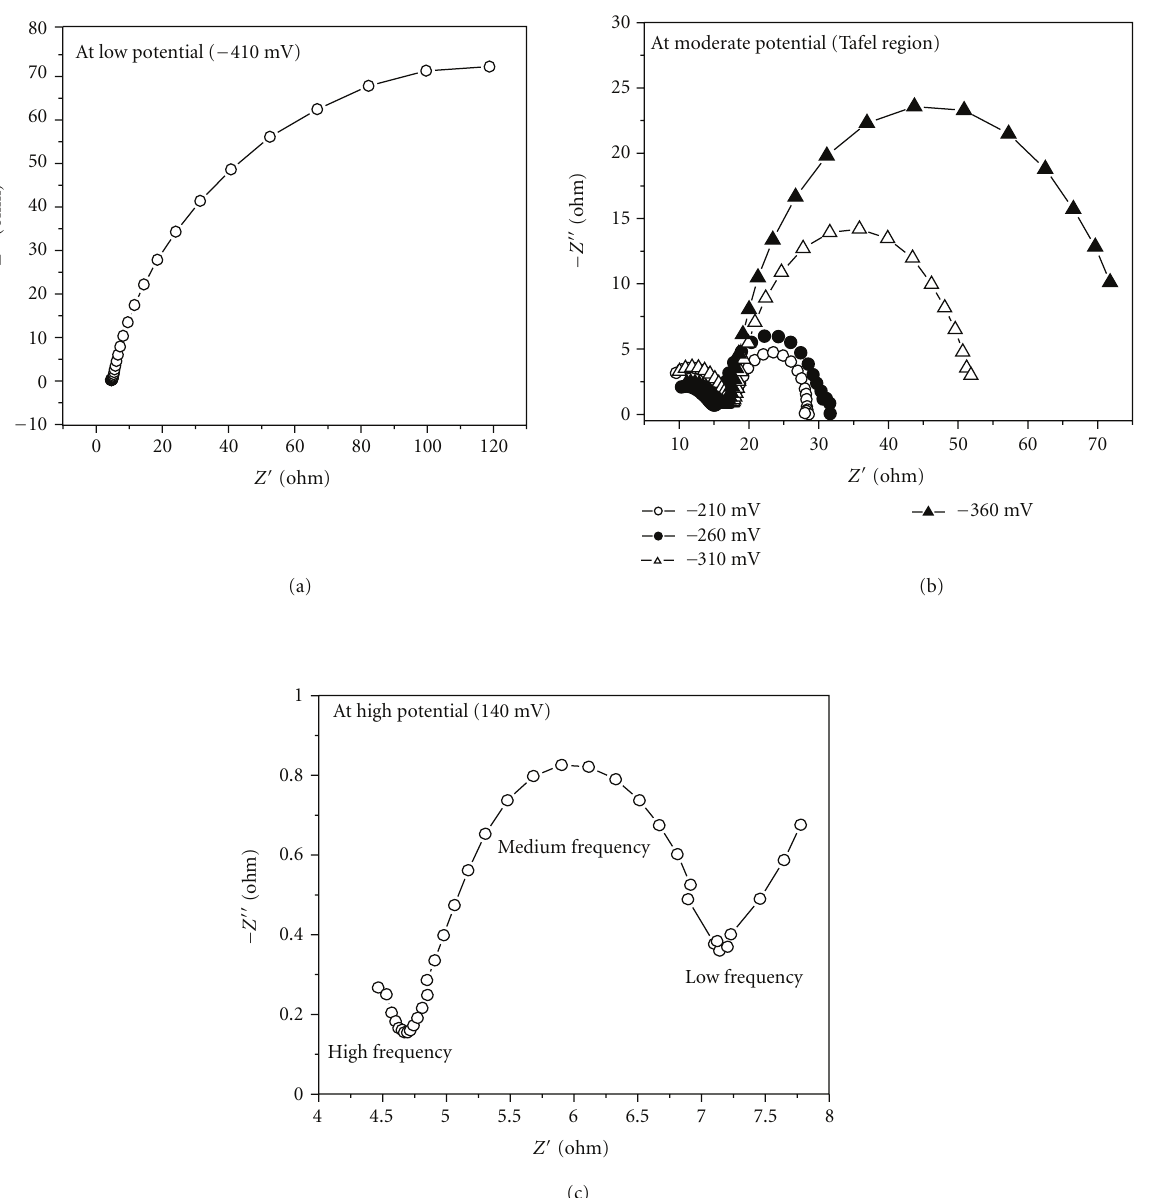
Figure 13: Impedance spectra for methanol oxidation on Pt-Pd/C catalyst at di ff erent potentials in a solution containing 0.5 MNaOH and 1.0M